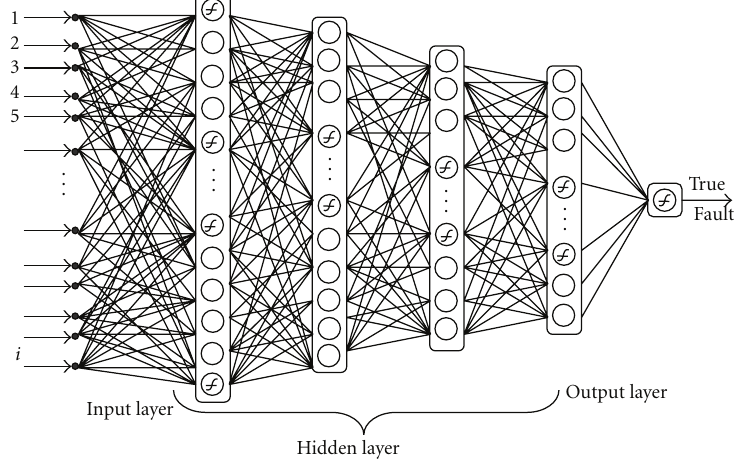
Figure 11: A typical multilayer perceptron